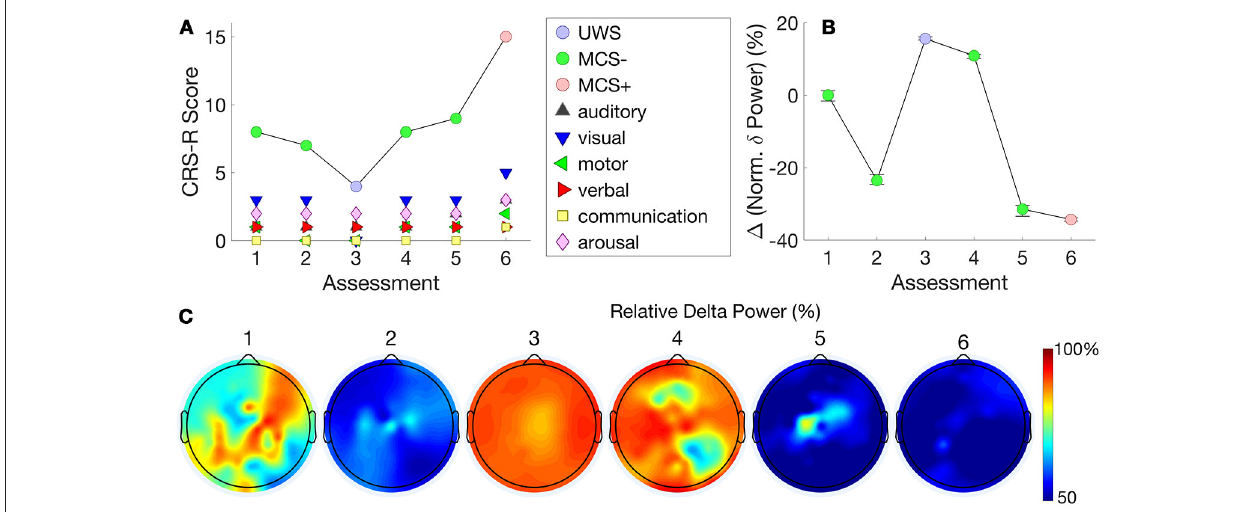
FIGURE 4 | Patient 3 (MCS- to MCS + ) - The trajectory of CRS-R scores (A) is juxtaposed with normalized delta power, averaged over all channels (B) . The relationship between these measures indicates that changes in CRS-R scores were inversely associated with delta power. (C) plots normalized delta power topography at each